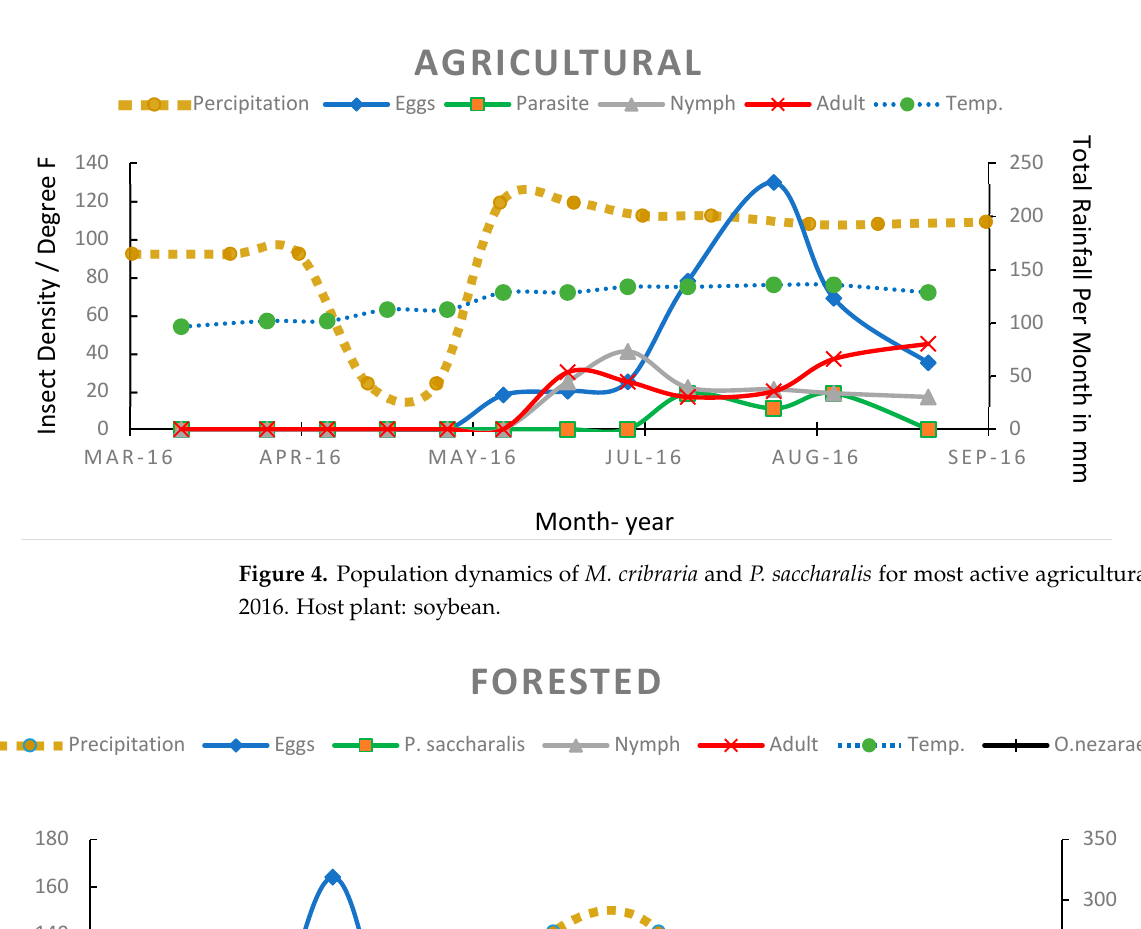
Figure 3. Population dynamics of M. cribraria and P. saccharalis for most active urban site in 2016. Host plant: kudzu.